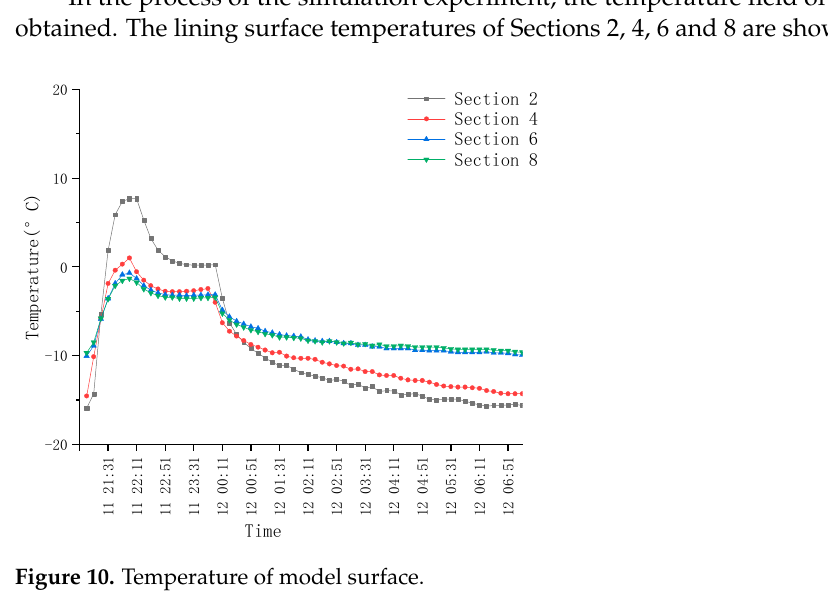
Figure 11. Temperature behind the lining. 4.2. Cross ‐ Section Temperature Distribution The temperature fluctuation of the surrounding rock, lining back, and lining surface is shown in Figure 12. 05 08:0705 18:0706 04:0706 14:0707 00:0707 10:0707 20:0708 06:0708 16:0709 02:0709 12:0709 22:0710 08:0710 18:0711 04:0711 14:0712 00:0712 10:0712 20:0713 06:0713 16:07 -10-8-6-4-2024 68 Temperature( ° C) Surrounding rock Behind the lining Suface of the lining Time Figure 12. Temperature distribution of the cross ‐ section.